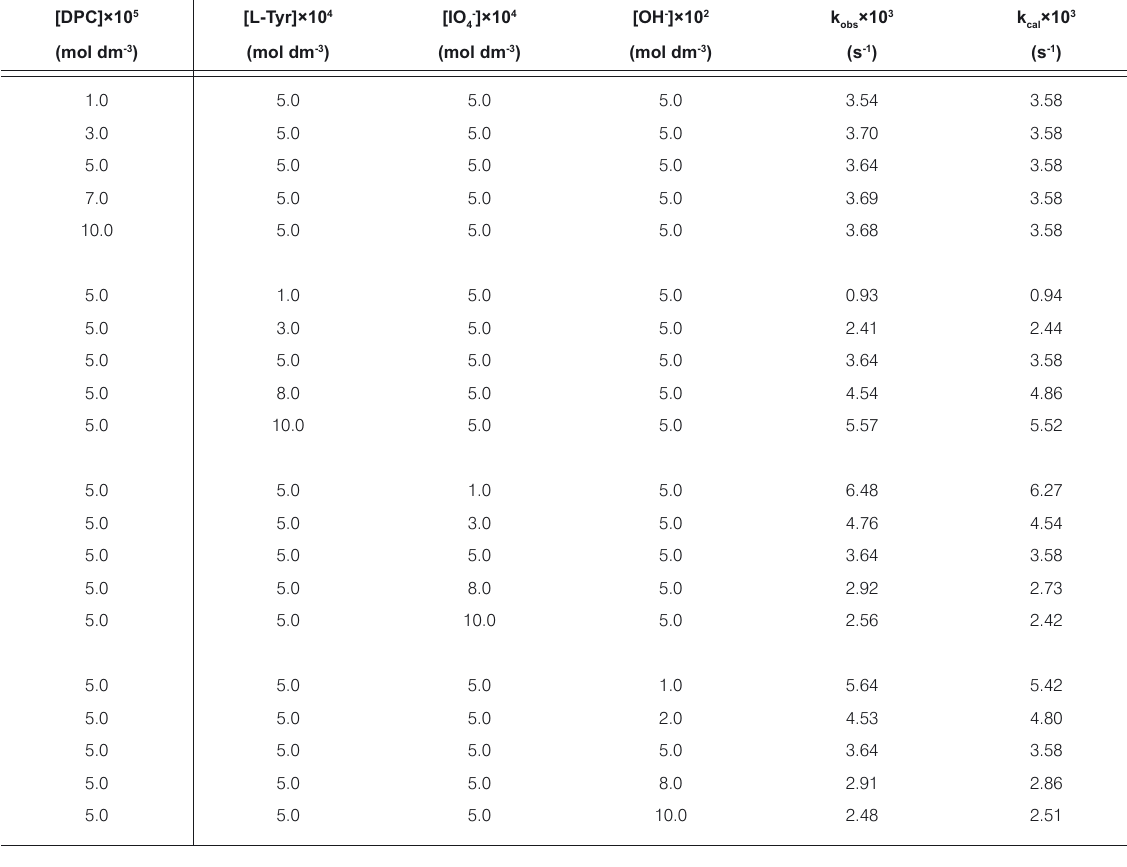
Table 1. Effect of [DPC], [L-Tyr], [IO 4- ] and [OH - ] on diperiodatocuprate(III) oxidation of L-tyrosine in alkaline medium at T = 298.1 K, I = 0.10 mol dm -3